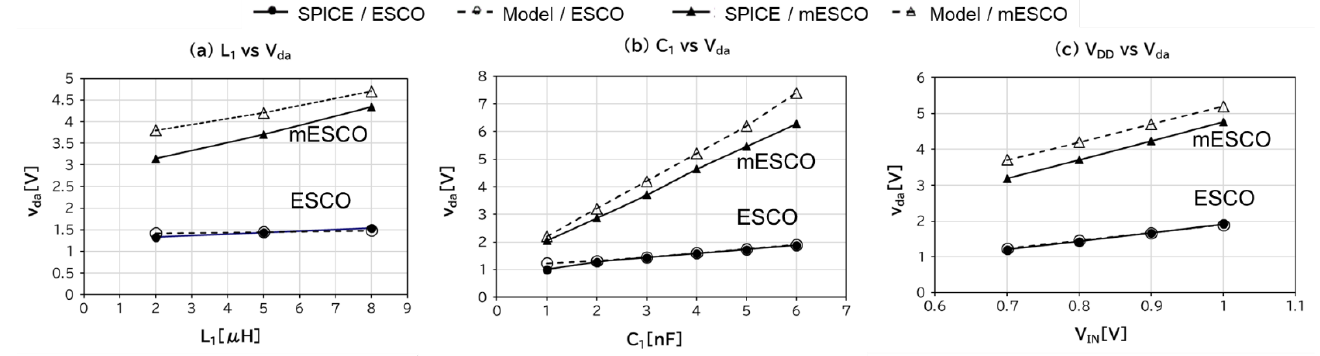
Figure 13. vda of ESCO and mESCO as a function of L 1 ( a ), C 1 ( b ), and V IN ( c ).